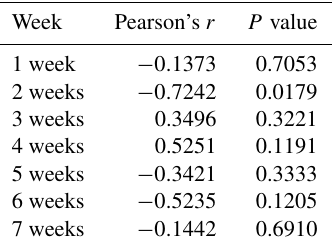
Table 3. Correlations between the average methylation level of pro- moter region and PLIN1 expression level ( n = 10).